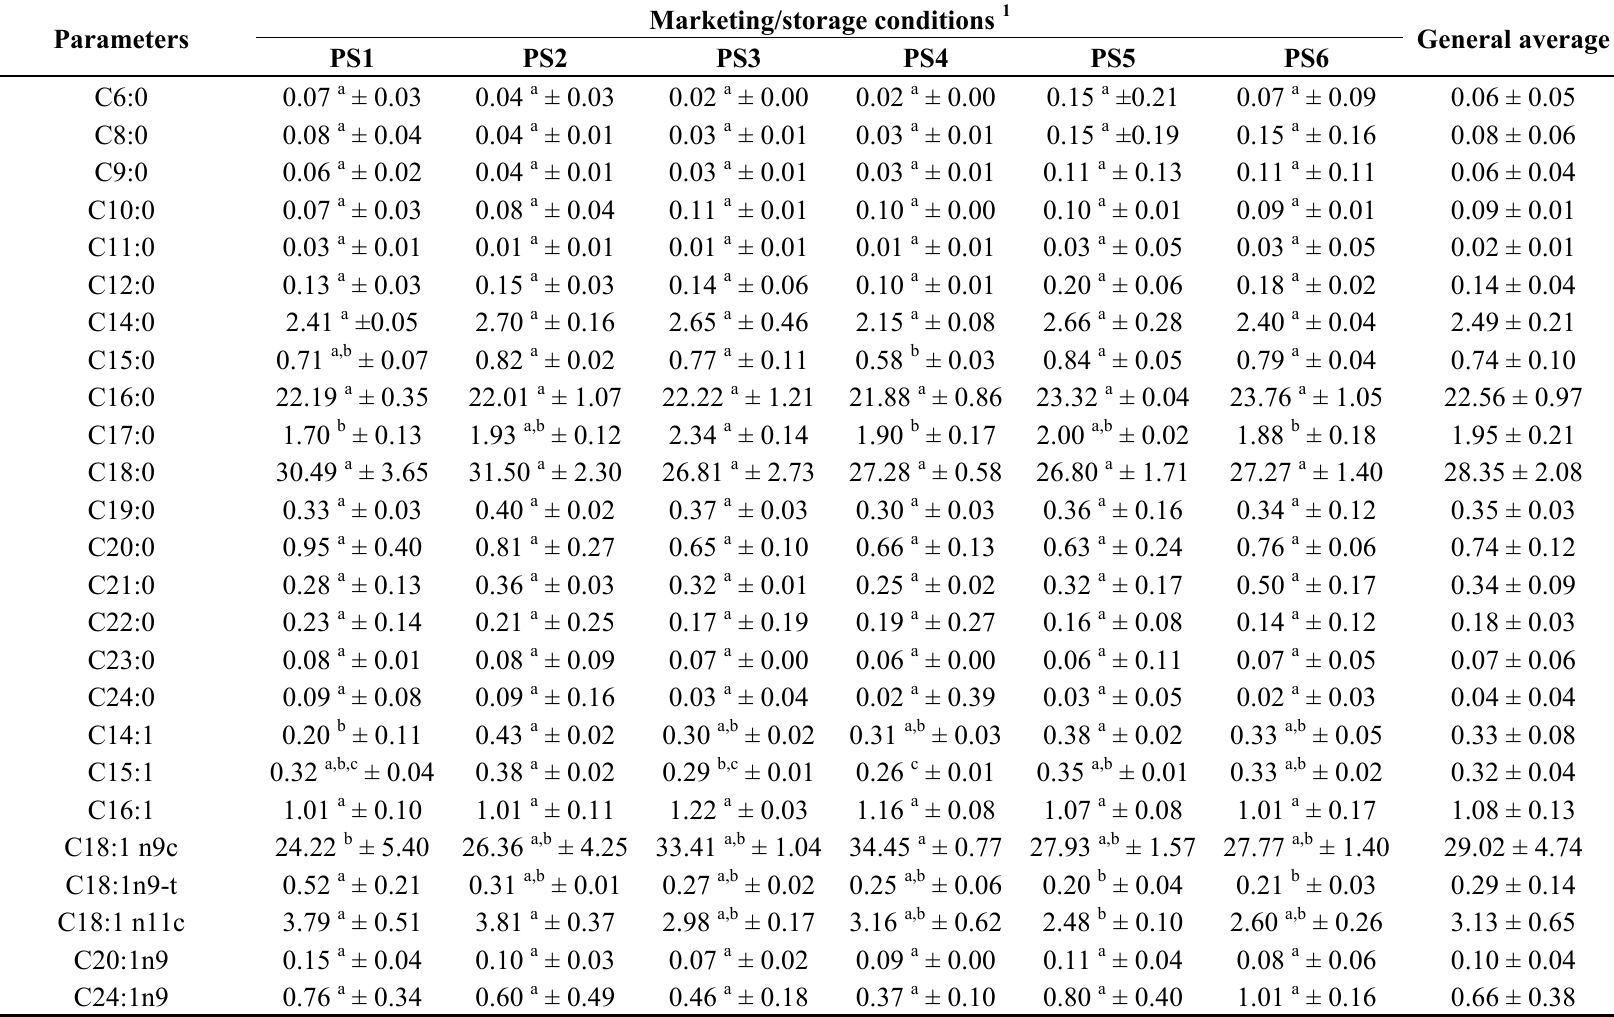
Table 3. Fatty acids profile (% area) of goat “sarapatel” marketed under different storage conditions.